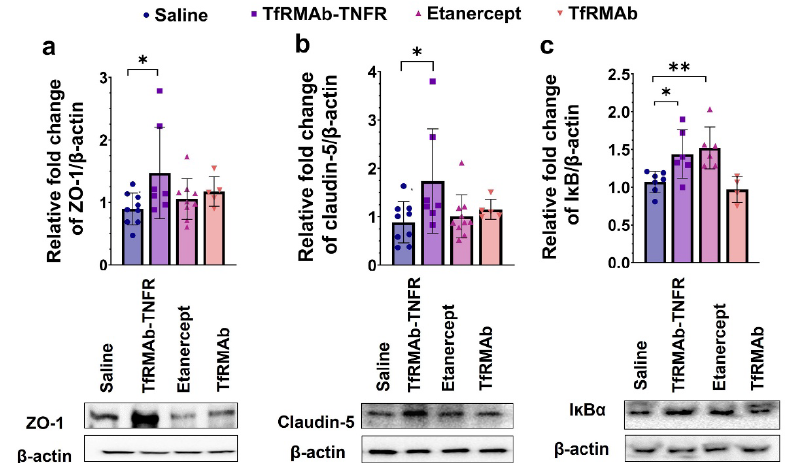
Figure 7. Effect of TfRMAb-TNFR on BBB tight-junction proteins and brain inflammation. Chronic TfRMAb-TNFR dosing in aged APP/PS1 mice significantly increased ZO-1 ( a ) and claudin-5 ( b ) compared to the saline-treated mice measured using Western blotting of the cerebrum homoge- nates. Both TfRMAb-TNFR and etanercept increased I ĸ Bα in the cerebrum homogenates compared to the saline-treated mice ( c ). Data are presented as mean ± SD of n = 4–9 per treatment group, and data were analyzed using the one-way ANOVA with the Holm Sidak’s post hoc test. * p < 0.05 and ** p < 0.01 for the indicated comparisons.